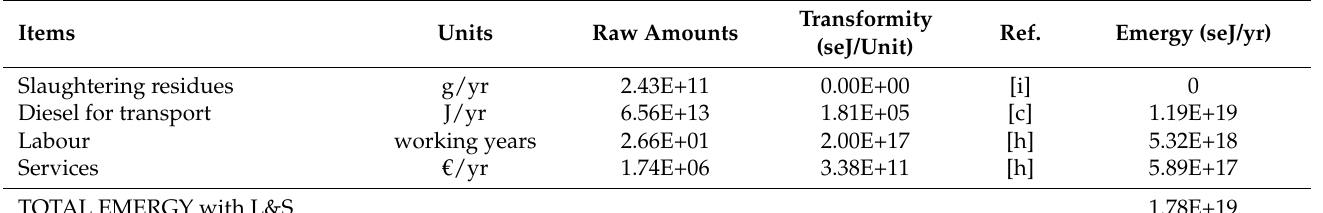
Table 2. Emergy table of transportation